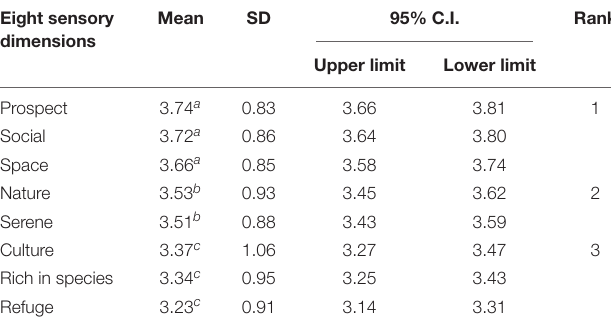
TABLE 1 | Perceived characteristics in blue